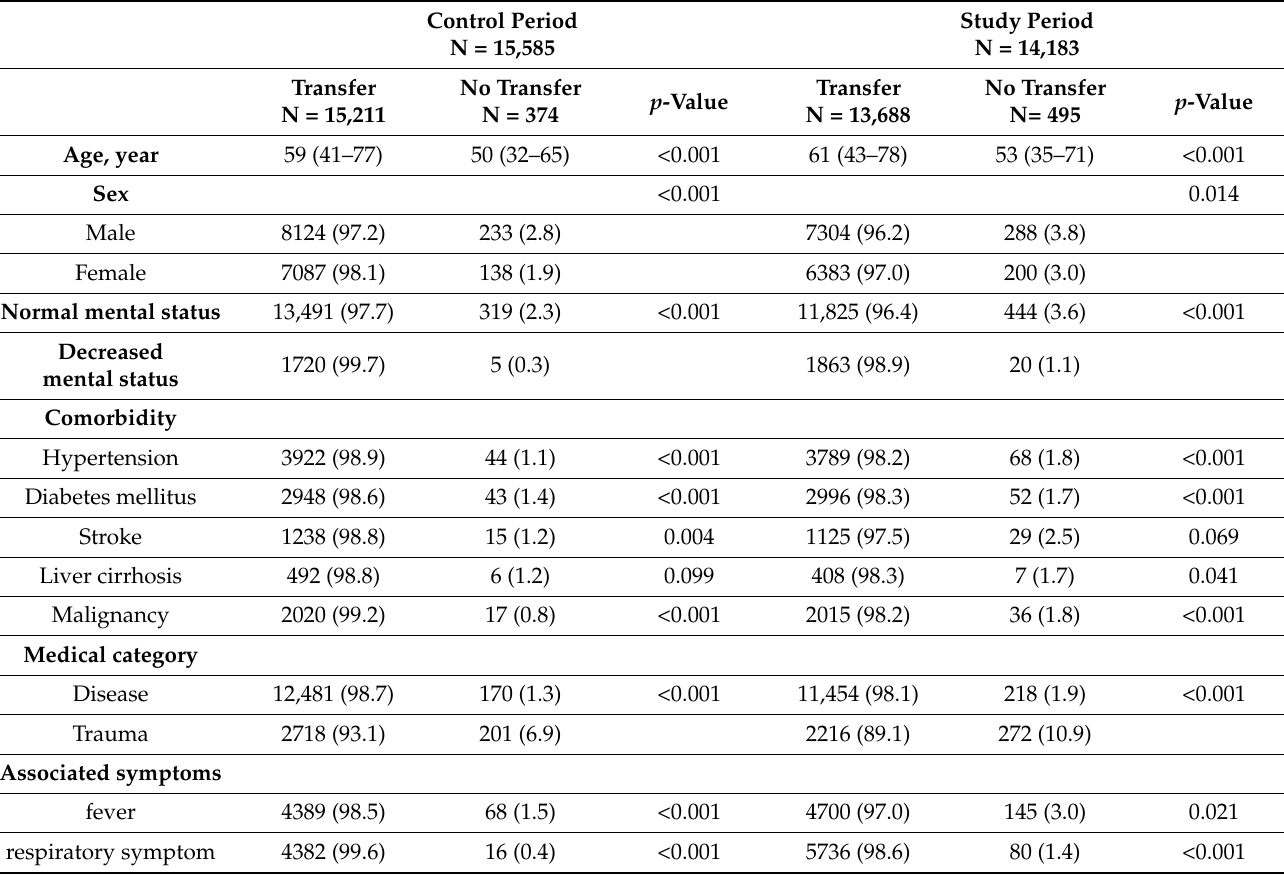
Table 3. Characteristics of patients who failed to use EMS transport with a shock index ≥